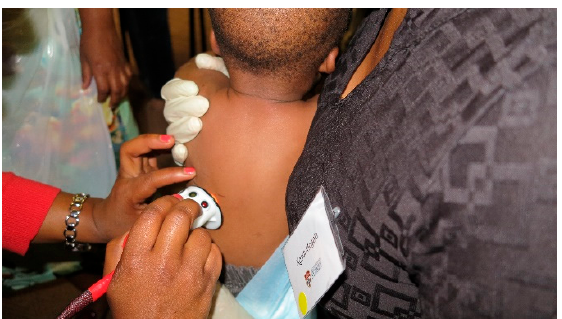
Figure 2. NIR measurement conducted on the subscapular site using the Ocean Optics QE Pro NIR Device.